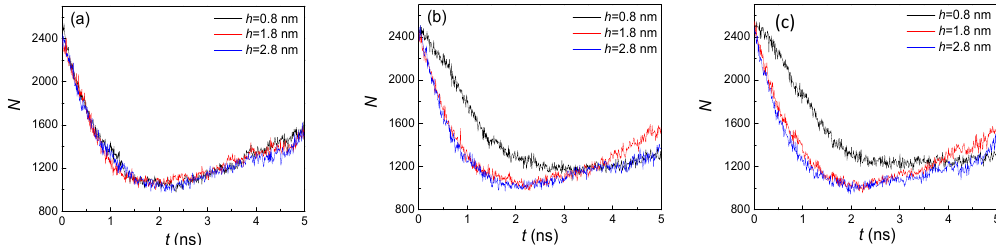
Figure 8. The statistical number of liquid argon atoms with three groove heights and widths of ( a ) 1.8, ( b ) 2.4, and ( c ) 3.2 nm on hydrophobic surfaces.